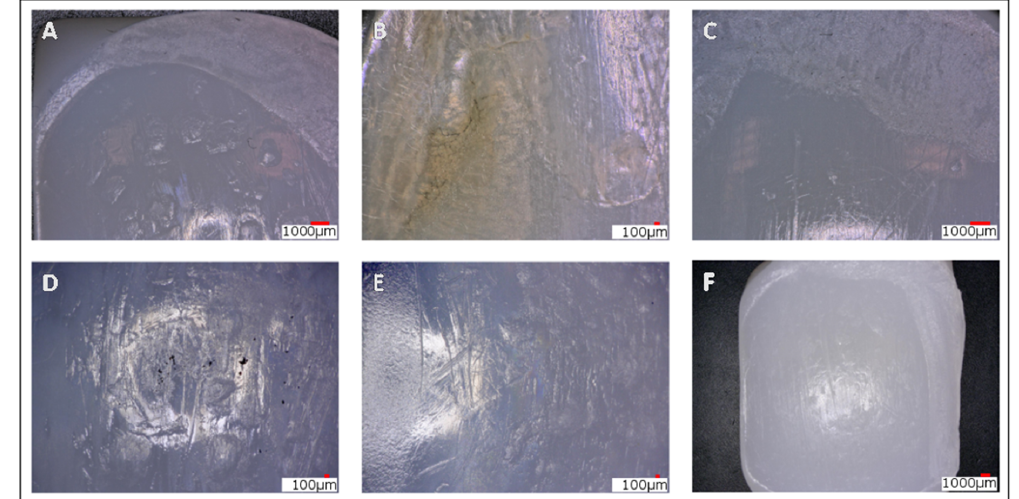
Figure 2. ( A ) Edge loading and abrasion in the anterior medial border of the inlay, pitting throughout the inlay, small scratches; ( B ) delamination at the anterior medial border of the inlay (noticeable at the brown change in color little pitting and scratching; ( C ) abrasion, scratching, and little pitting; ( D ) embedded particles (small black dots, possibly metal debris), a lot of scratching and pitting; ( E ) burnishing (see changes of regular manufacturing marks on the left side to a polished surface); ( F ) surface deformation, edge loading, abrasion, and a little pitting and scratching.